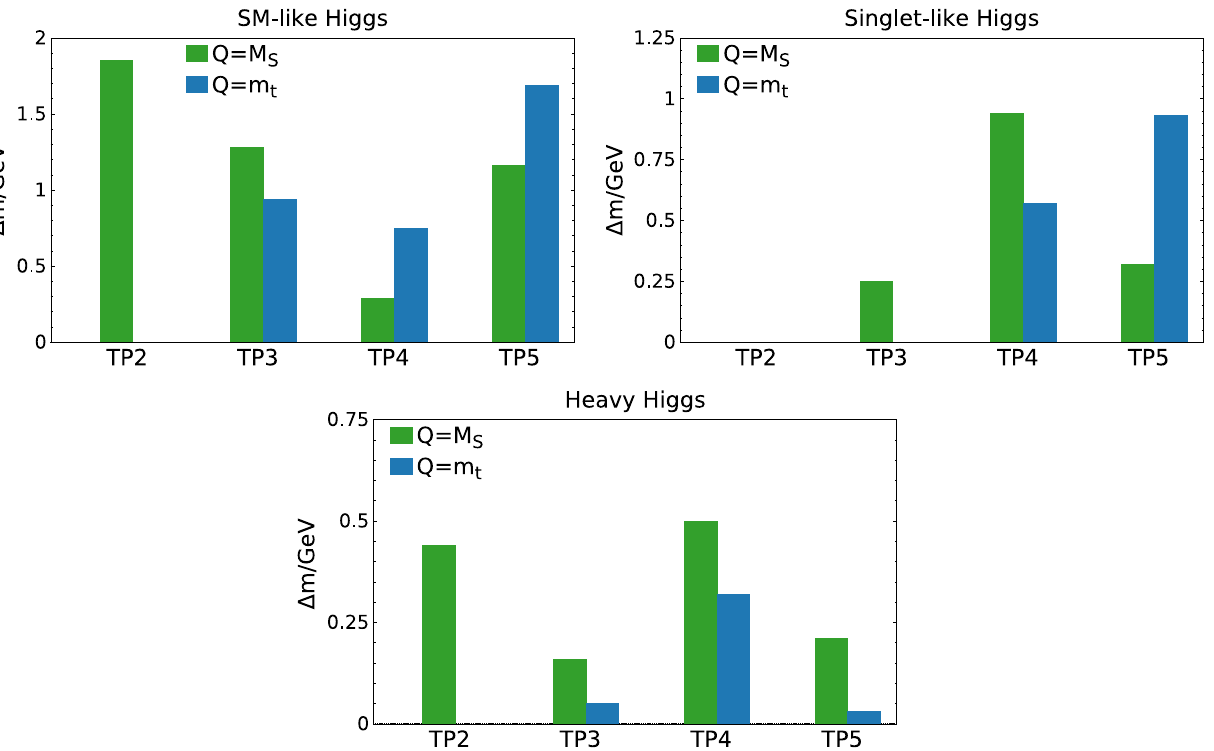
− M NC DR | from Table 10. For TP2 higher-order corrections to the mass of the singlet-like field are h h